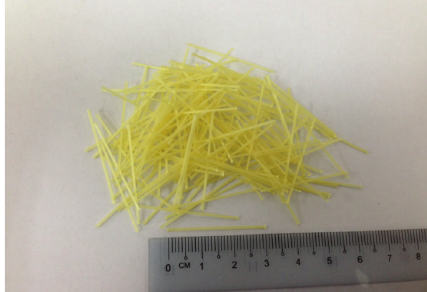
Figure 5: Photograph of polyvinyl alcohol